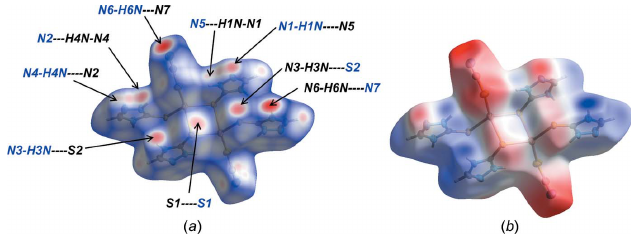
Figure 4 Aview of the Hirshfeld surface for (I) mapped over ( a ) d norm and ( b ) the electrostatic potential; the red and blue regions represent negative and positive electrostatic potentials,